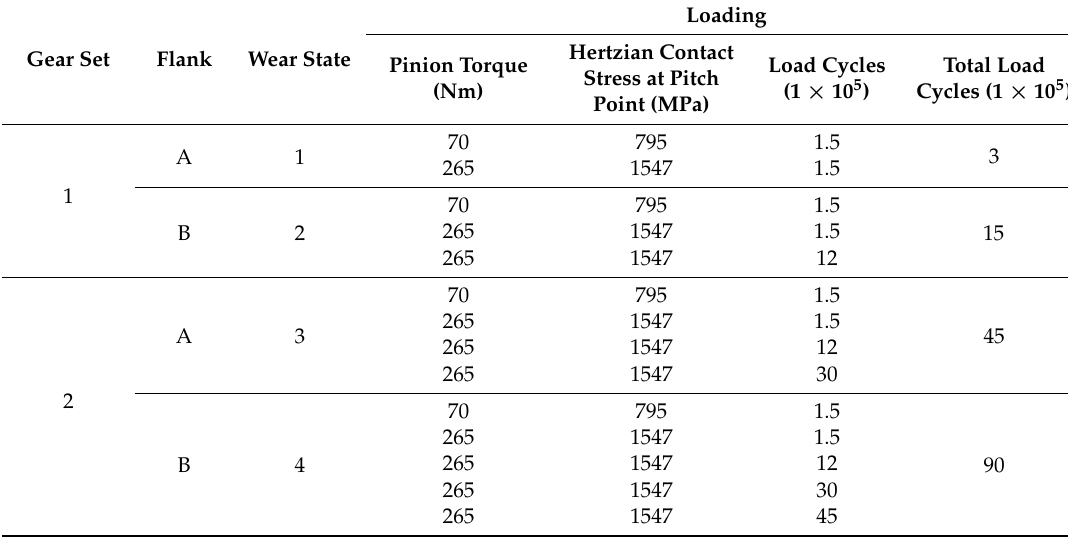
Table 1. Test sequence for each tooth flank [5].